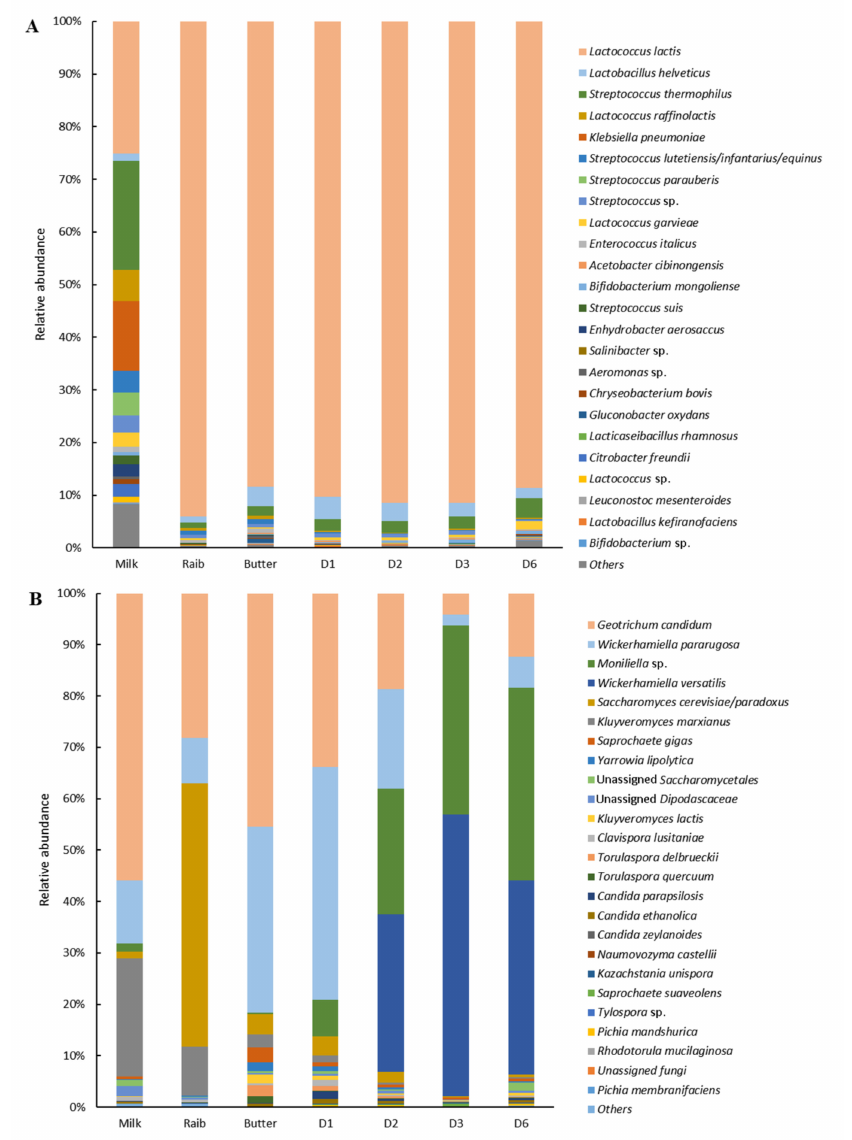
Figure 7. Bacterial ( A ) and fungal ( B ) diversity during Smen preparation stages (D1, D2, D3, D6: Smen after one, two, three, and six months of maturation, respectively) determined by a metagenetic